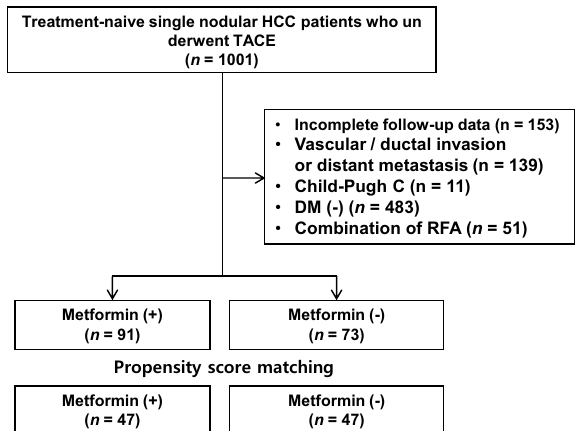
Figure 1. Flow chart of the study population. HCC hepatocellular carcinoma, TACE transarterial